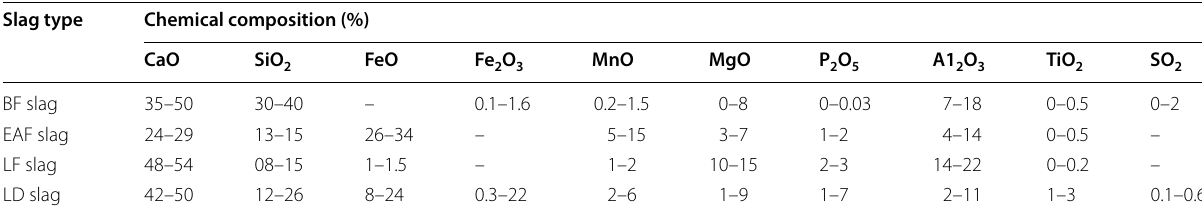
Table 4 Typical chemical compositions of BF, electric arc furnace (EAF), ladle furnace (LF), and LD slag (Ashrit et al., 2015; Faleschini et al., 2016; Haha et al., 2011; Luxán et al., 2000; Radenović et al., 2003). Slag